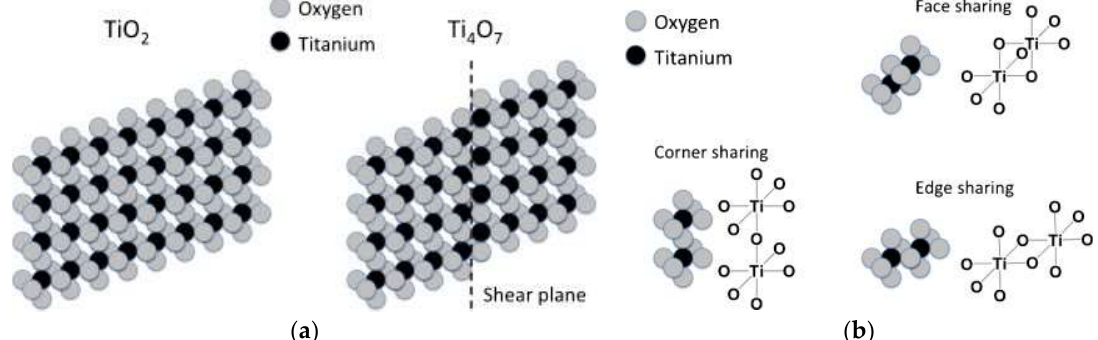
Figure 7. ( a ) Difference between TiO 2 and Ti 4 O 7 (Magneli phase) structure ( b ) Different orientations of TiO 2 octahedra in Magneli phase materials. Reproduced from [92], Copyright 2010, Elsevier.